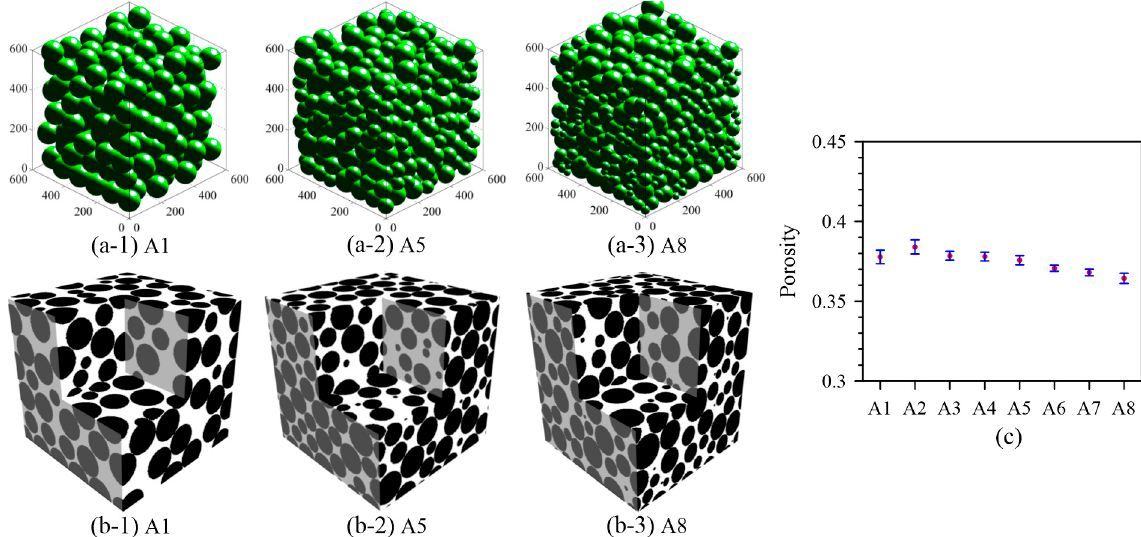
Figure 3. Digital 3D images and porosity evolution of sedimentation model. ( a-1 , a-2 , a-3 ) are A1, A5, and A8 sub-models, respectively; ( b-1 , b-2 , b-3 ) are digital representations of corresponding sub-models; ( c ) Porosity evolution.